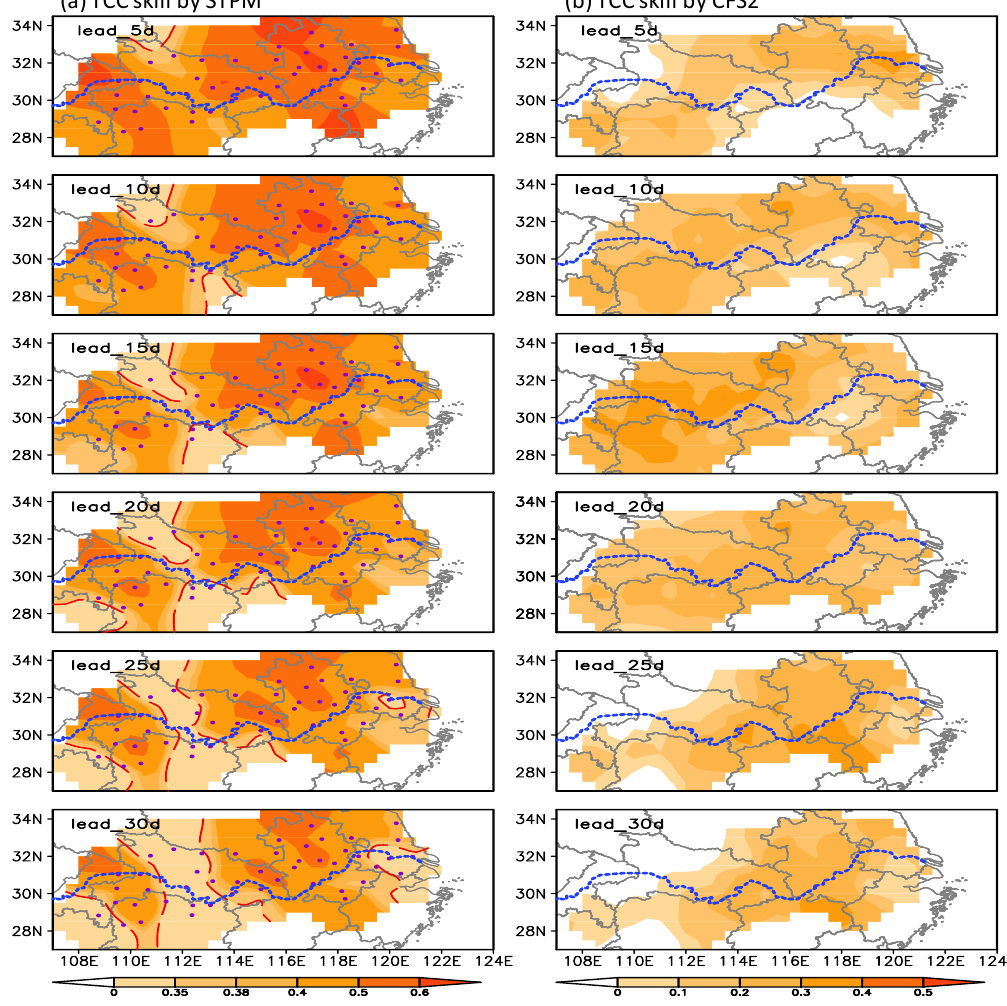
Figure 6. Distribution of TCCs between 5–30-day lead (from top to bottom) forecasted and observed 30–80-day rainfall anomalies over the MLRYB for the period 2003–2010, in which the red dashed contour is the threshold of the 95% confidence level based on the Student’s t -test: ( a ) STPM, where purple dots denote the 48 stations over the MLRYB, the TCC values on the gauge stations are gridded to a 0.5 × 0.5 latitude–longitude grid using Cressman interpolation schema [31]; and ( b ) CFS2, where the grids are also interpolated into 0.5 × 0.5 latitude–longitude. The blue dashed line is the Yangtze River. Note that the color bars in ( a ) and ( b ) are different.